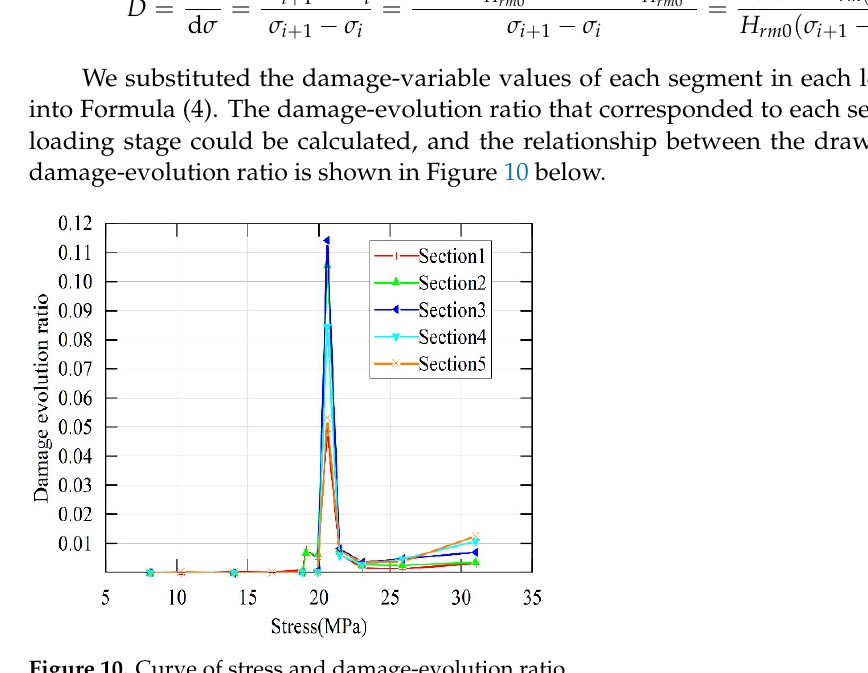
Figure 10. Curve of stress and damage-evolution ratio.